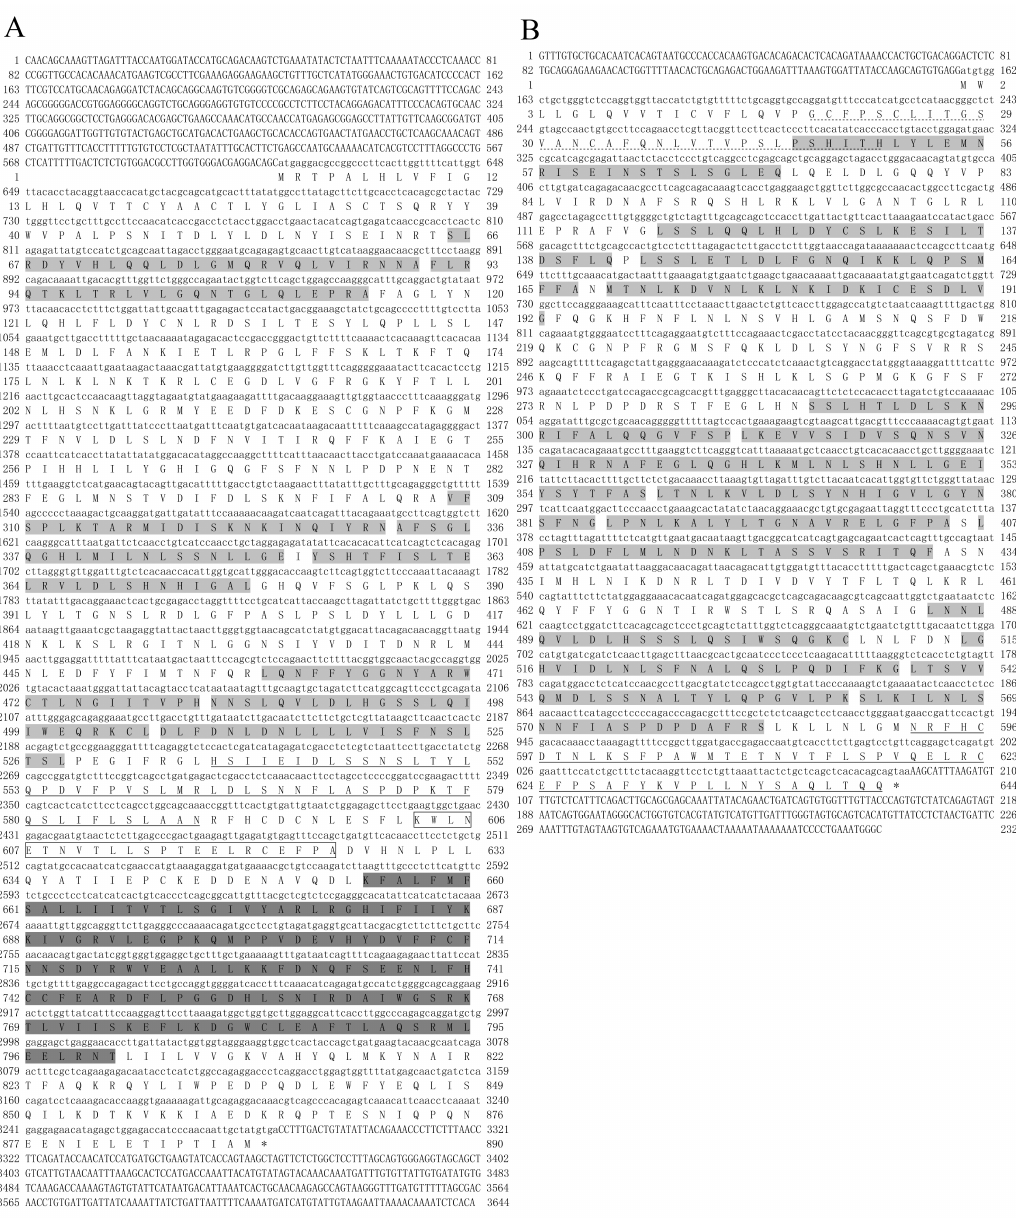
Figure 1. The full-length cDNA and deduced amino acid sequences of ToTLR5M ( A ) and ToTLR5S ( B ). The leucine-rich repeat (LRR) and LRR-NT domains are highlighted in light gray and by dotted lines, respectively. The LRR-CT domains are underlined in ToTLR5S ( B ). The transmembrane region is indicated by box and the Toll / IL-1 receptor (TIR) domain is marked with gray; termination codon is indicated with